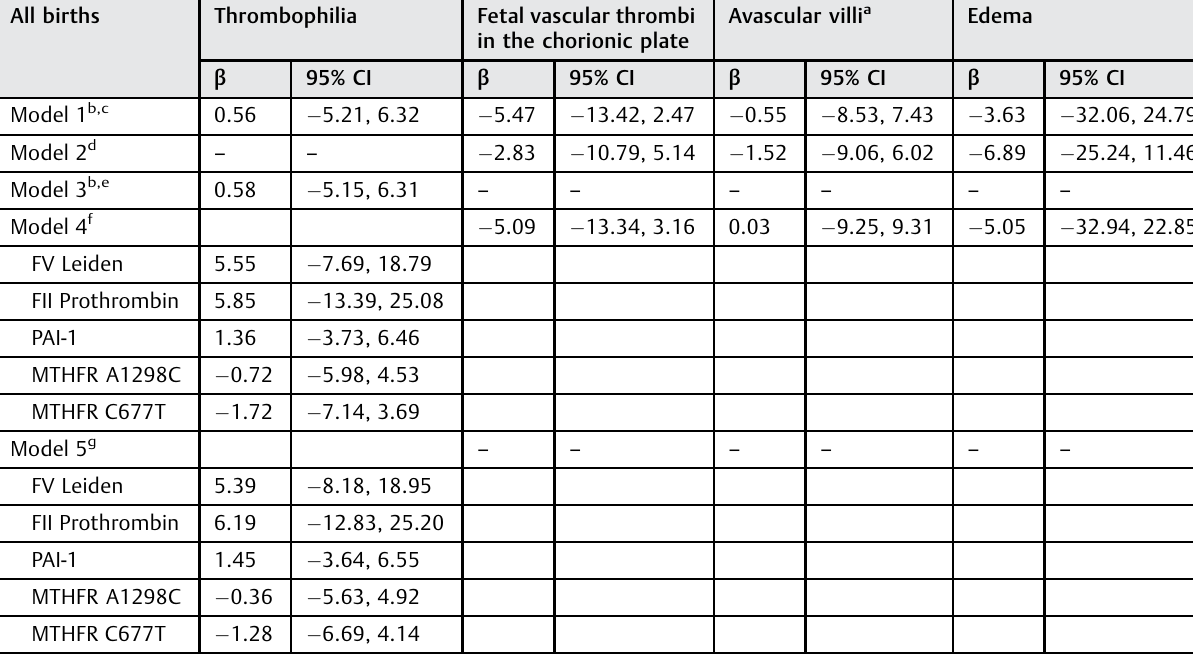
Table 6 Regression coef fi cients for birth weight for gestational age percentile modeled as a function of presence of fetal thrombophilia markers and placental characteristics related to fetal vascular malperfusion All